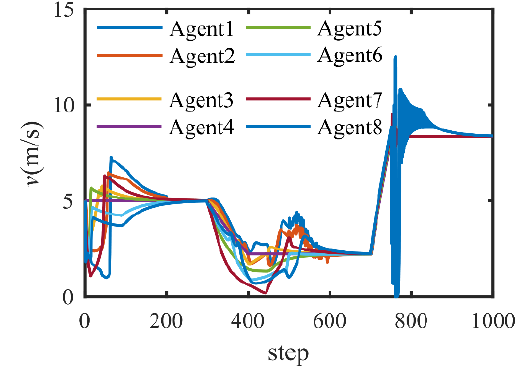
Figure 8. Velocity (test 2).